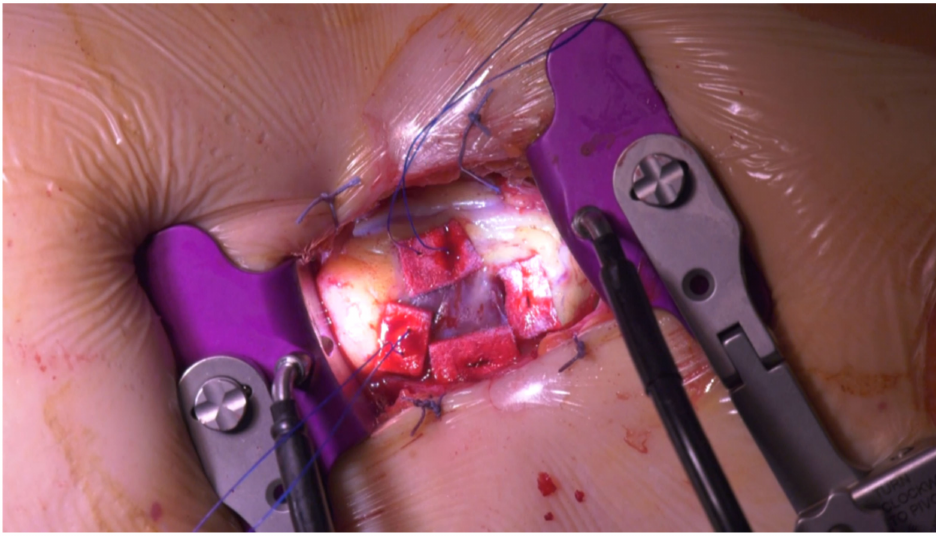
Figure 1. Two haemostatic orthogonal U-shaped 2/0 polypropylene stitches on the left ventricular